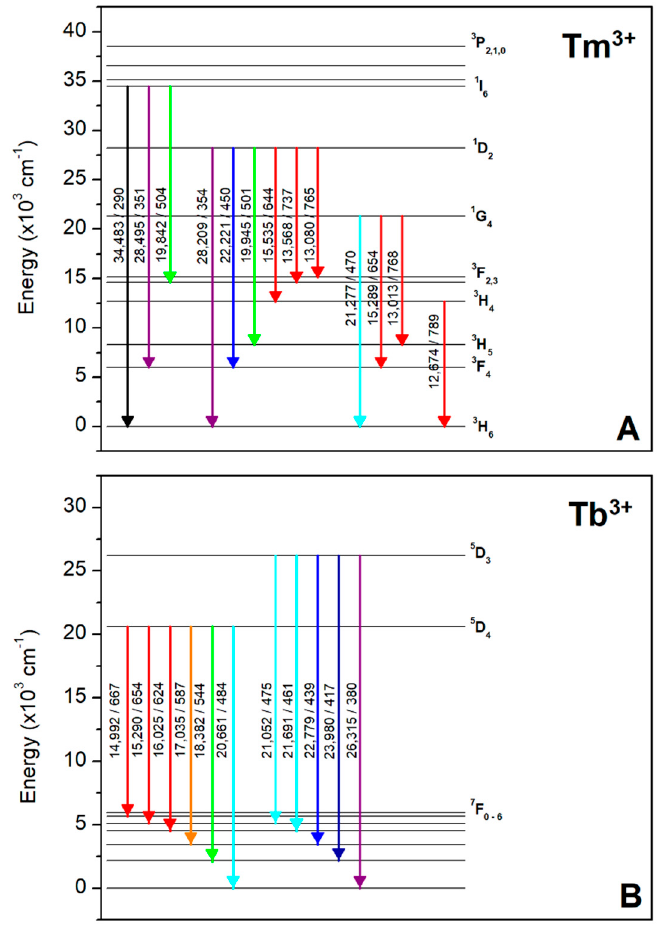
Figure 2. The f–f electronic transitions for trivalent Tm (panel A ) and Tb (panel B ) rare-earth ions. The numbers next to arrows denote the energy (cm − 1 ) and wavelength (nm) of respective transitions.